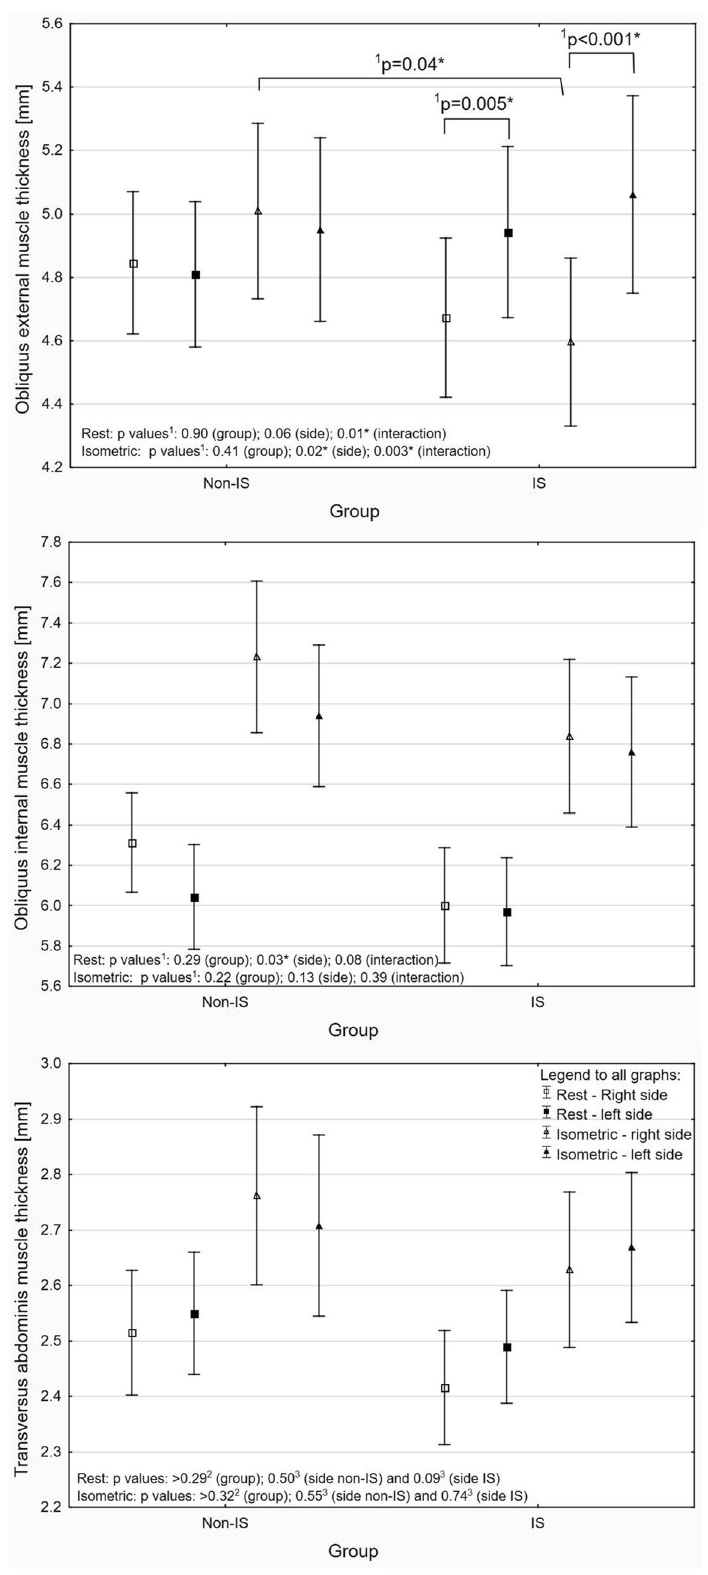
Figure 1. Absolute muscle thickness at rest and during isometric contraction in control and idiopathic scoliosis groups with p values from ANOVA 1 , Mann–Whitney U 2 test or Wilcoxon test 3 (*significant